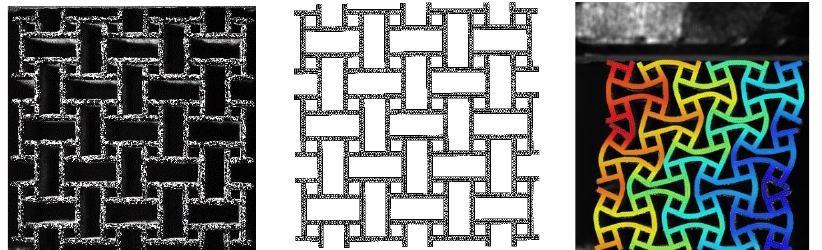
Fig. 3. On the left is the recorded structure prior to deformation. In the middle is the FE mesh based on the CAD model of the structure. The mesh is applied to the surface of the structure in its initial state. On the right, the structure including the mesh have already been deformed.